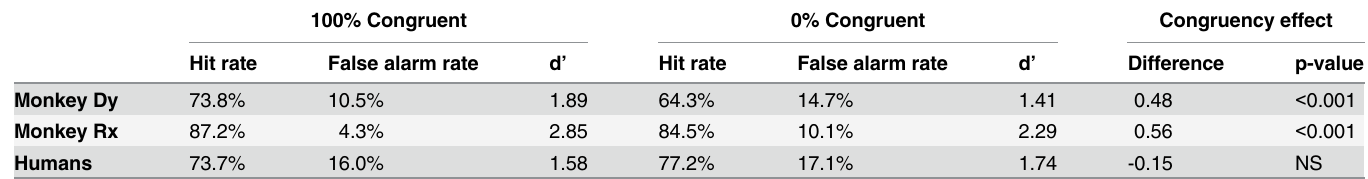
Table 3. Go-response rate (hits and false alarms) as well as sensitivity (d ’ ) in the “ Noisy background ”